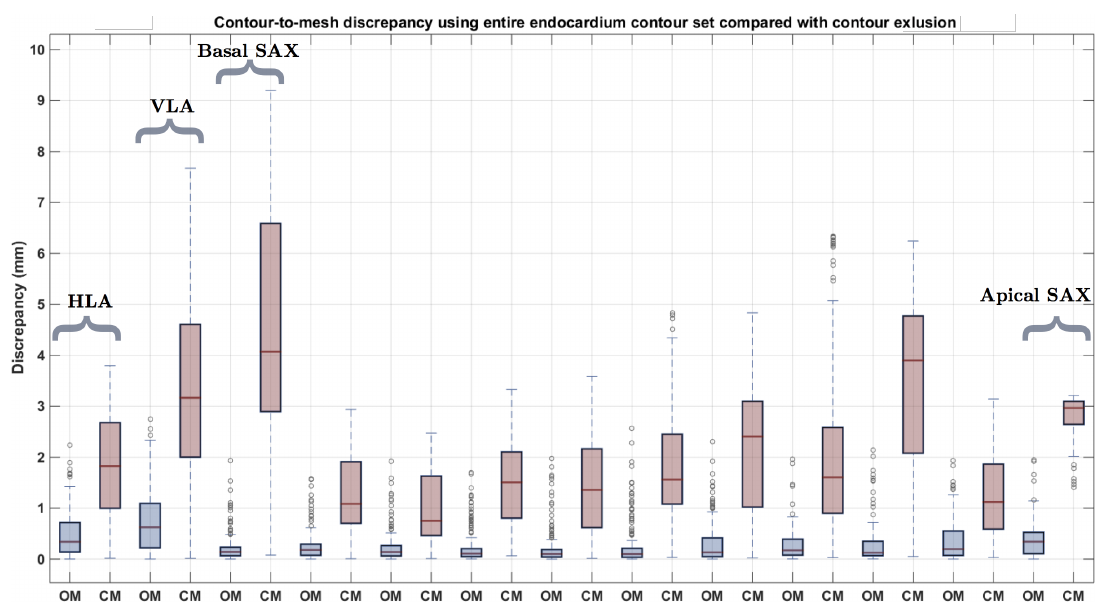
Figure 10. Endocardial contour-to-mesh distance having built the mesh with the entire set of contours (labelled OM , which stands for “Original Mesh”, in blue) and excluded contour-to-mesh distance having built the mesh without the excluded contour (labelled CM , which stands for “Computed Mesh”, in red).